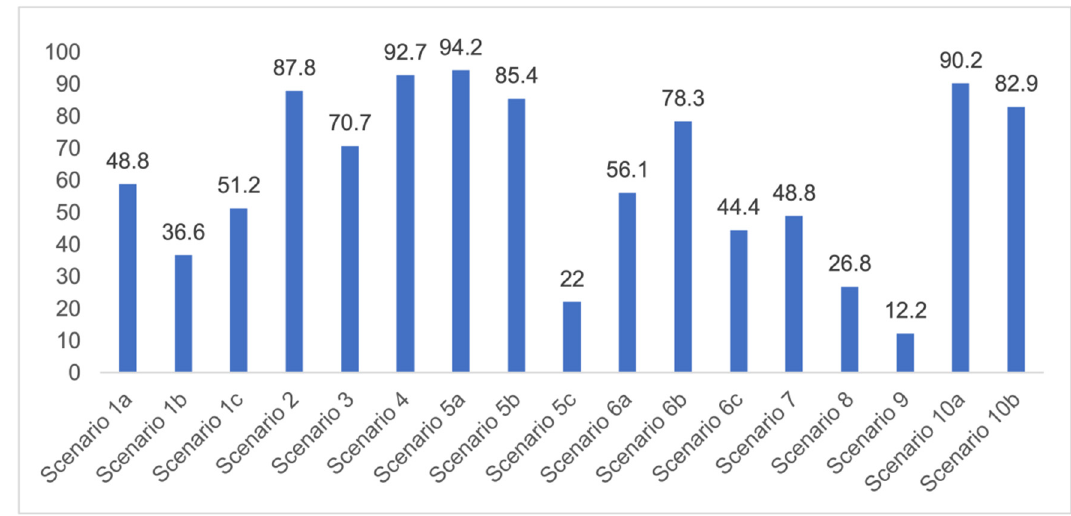
Figure 1. The percentage of correct questions answered by the surveyed students ( n = 42) for each of the clinical scenarios.